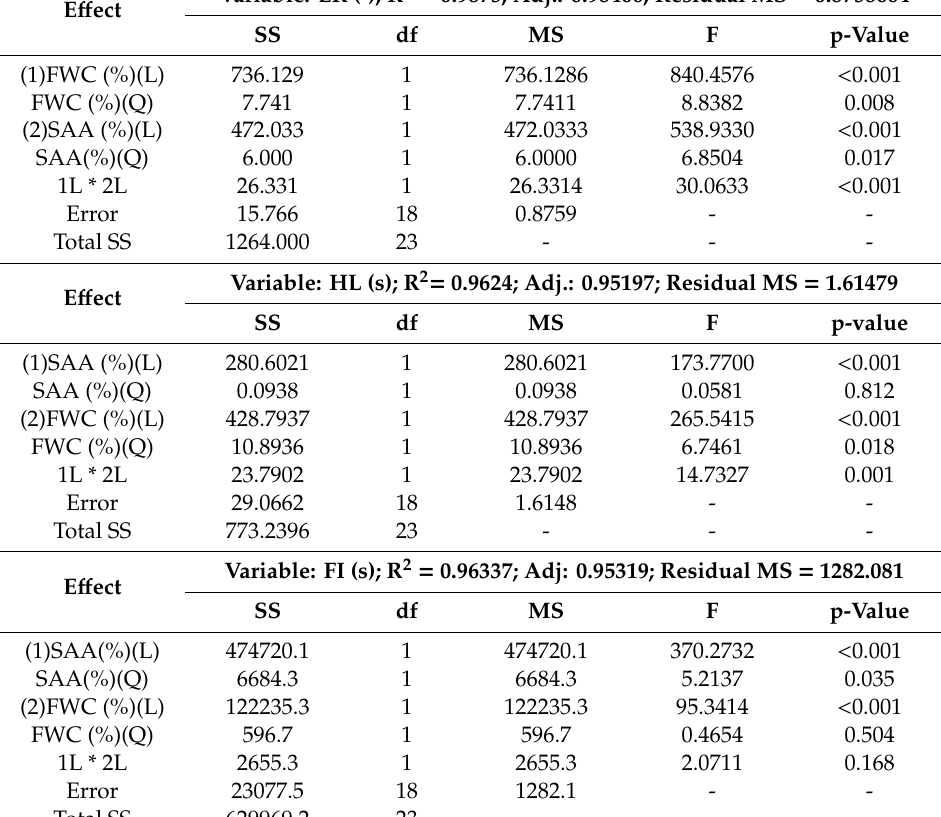
Figure 6. Response surface of the maximum ( a ) expansion ratio (ER), ( b ) half-life (HL) and ( c ) foam index FI against SAA content and foaming water content foaming water contents (FWC). Table 10. Evaluation of the e ff ect of SAA and FWC on ER, HL, and FI of the foamed bitumen. E ff